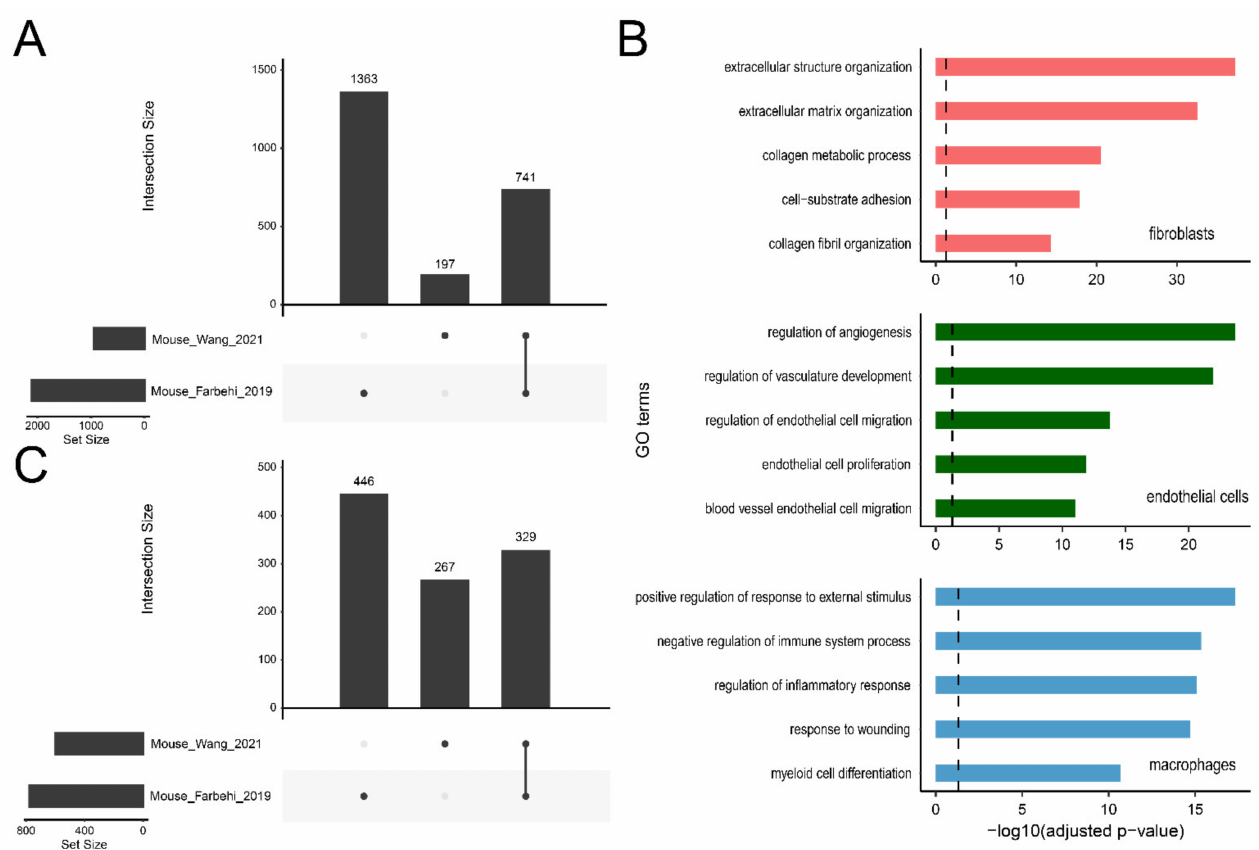
Figure 5. Upset plots of DEGs for three cell types combined ( A ) and fibroblast ( C ) between Mouse-Wang-2021 and Mouse- Farbehi-2019 datasets. Here, a total of 741 high confidence DEGs are detected for three cell types (fibroblasts, endothelial cells, and macrophages), including 329 DEGs for fibroblast. ( B ) Feature GO terms enriched for the high confidence DEGs of fibroblasts (upper panel), endothelial cells (middle panel), and macrophages (bottom panel). The dashed line represents the significance threshold of −